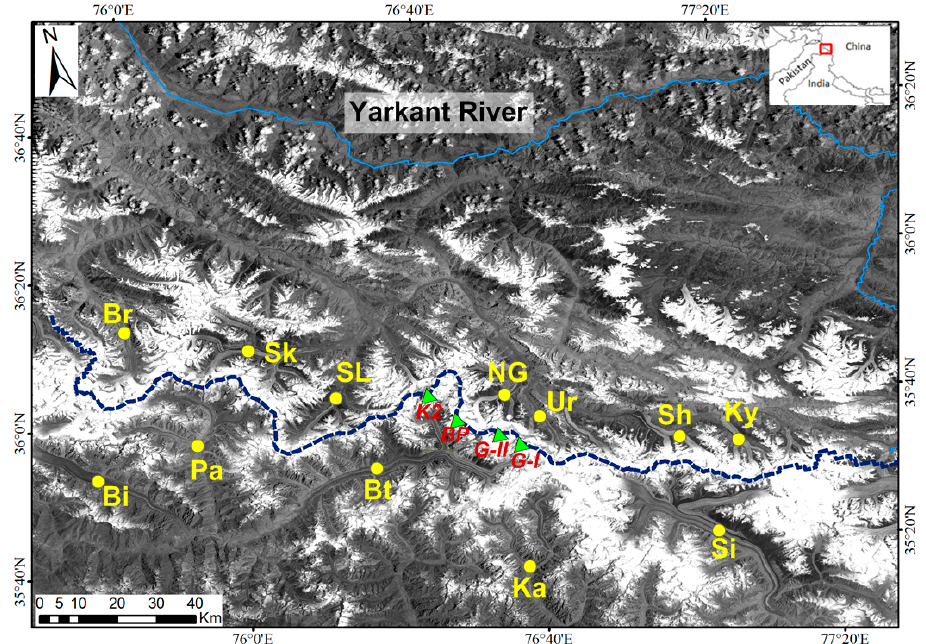
Figure 1. An overview of the study area. The background is the Landsat ETM+ image acquired on 21 July 2001. The blue line marks the Yarkant River, and the blue dashed line marks the boundary between glaciers on the southern and northern slopes. The green triangles represent four peaks (exceeding 8000 m a.s.l.) from north to south: K2, Broad Peak, Gasherbrum II and Gasherbrum I. The yellow points mark the glaciers mentioned in context. Abbreviations: Br = Braldu Glacier, Sk = Skamri Glacier, SL = Sarpo Laggo Glacier, NG = North Gasherbrum Glacier, Ur = Urbak Glacier, Sh = Singkhu Glacier, Ky = Kyagar Glacier, Si = Siachen Glacier, Ka = Kaberi Glacier, Bt = Baltoro Glacier, Pa = Panmah Glacier, Bi = Biafo Glacier.